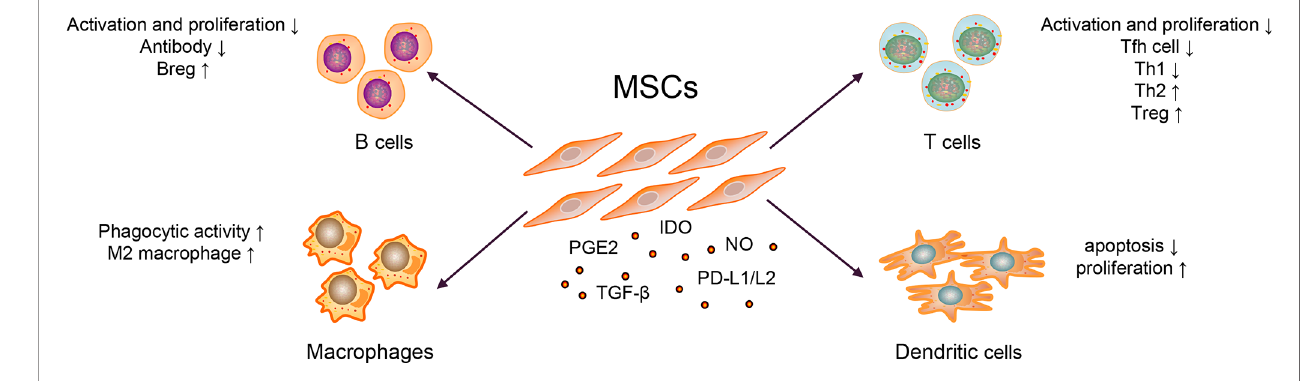
FIGURE 2 | Mechanisms of MSC Therapy